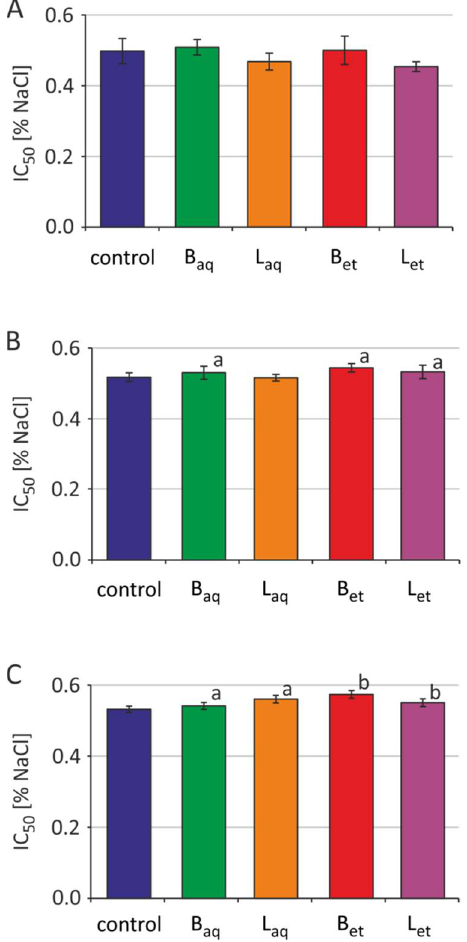
Figure 4. IC 50 parameter for control RBCs and erythrocytes treated with U. tomentosa extracts at a concentration of 100 µg/mL for 2 h ( A ), 5 h ( B ) and 24 h ( C ) (abbreviations as in Figure 1); a p < 0.05; b p < 0.001.